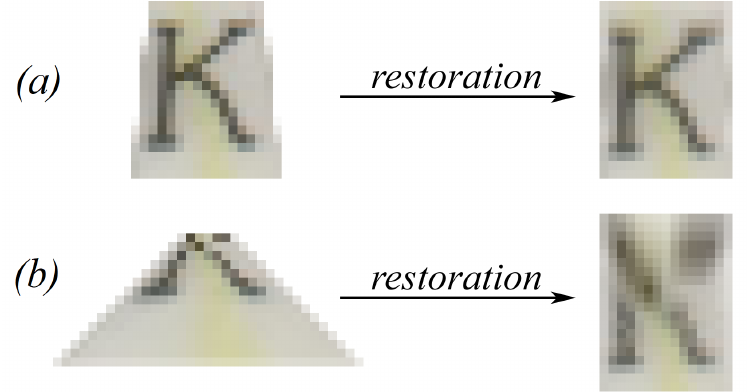
Figure 1. An example of document projective distortion ( a ) and the resulting quality of the extracted text regions ( b ).